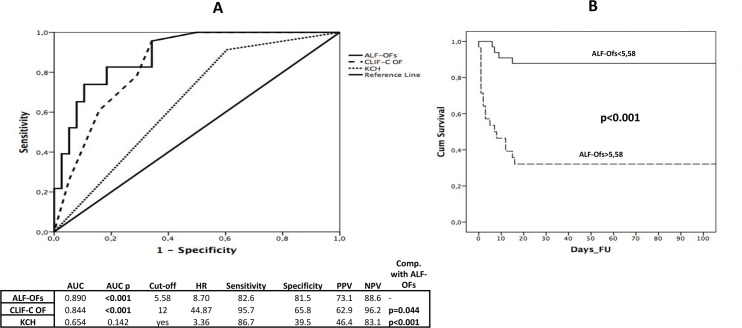
ALF OFs score characteristics.(a) ROC curves for ALF-OFs, CLIF-C OF and KCH for 3-month mortality in not-transplanted patients. (b) Kaplan Meier curve of ALF-OFs score for 3-month mortality in not-transplanted patients.